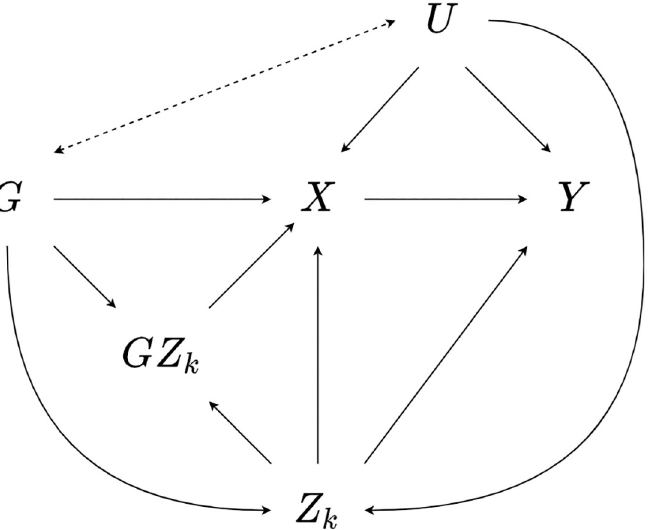
Fig 4. Illustration of collider bias when estimating ^ X . A diagram showing a situation in which conditioning on Z when G and U are simultaneously upstream associated with Z bidirectional